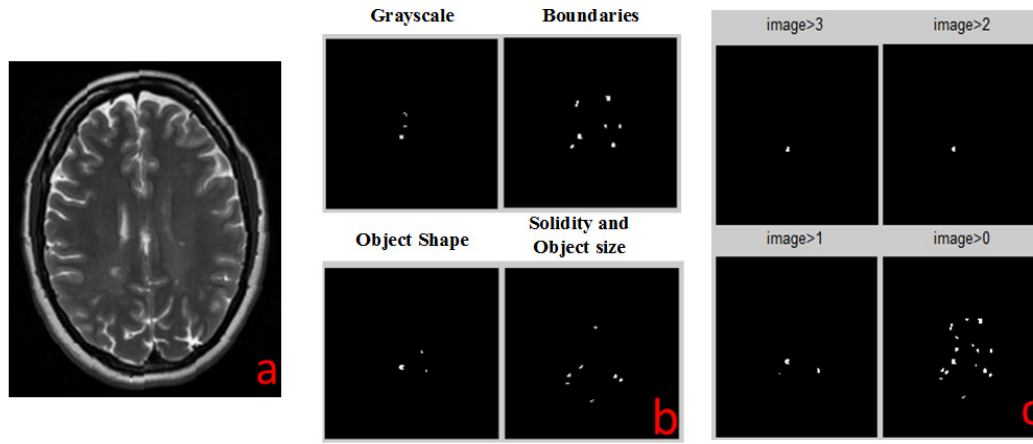
Figure 8. MS detection for image with T2_FSE type: ( a ) original Image; ( b ) results of all detection algorithms; ( c ) combination of all detection results, displaying pixels with value greater than a threshold value (see titles). The value of each pixel denotes the number of algorithms (out of 4) that detected this pixel as part of a positive suspected MS lesion.